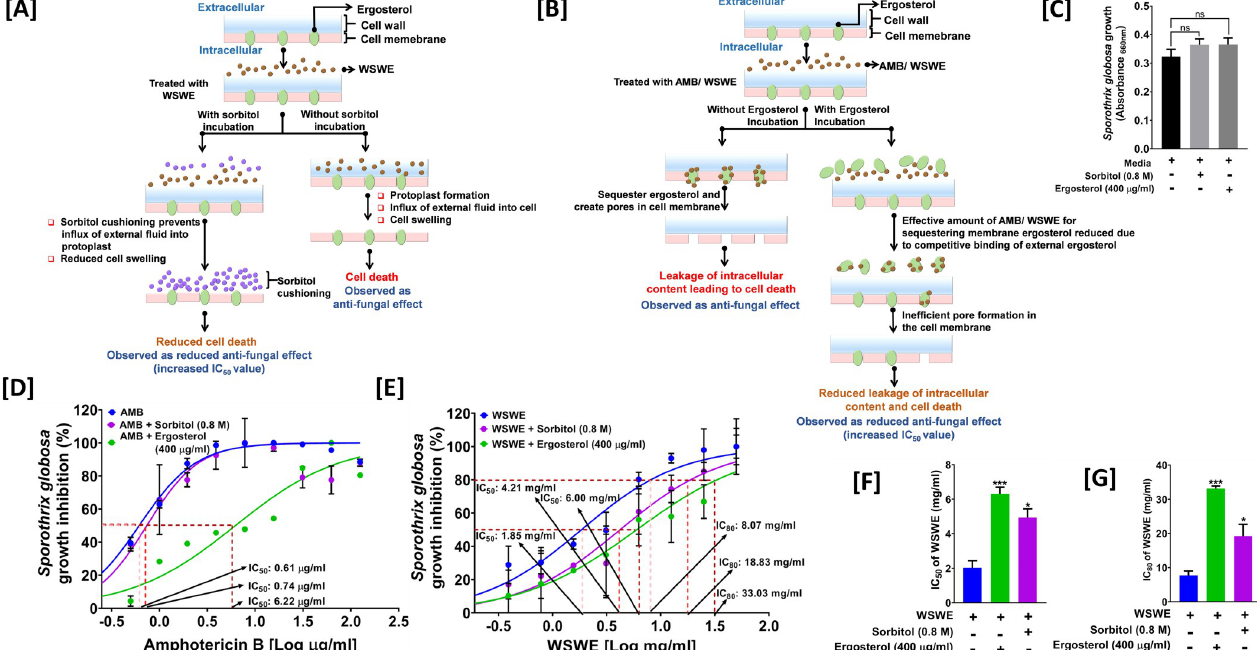
Fig 4. WSWE targets both cell wall and cell membrane of S . globosa . [A, B] Schematic depiction of the principles behind sorbitol protection (A) and ergosterol binding (B) assays to assess the effect of WSWE treatment on cell wall and cell membrane, respectively, of S . globosa . [C] Bar graph showing the effect of ergosterol or sorbitol alone on the growth of S . globosa cells. [D, E] Comparative dose response curves demonstrating the effect of sorbitol and ergosterol on the antifungal efficacies of amphotericin B (D) and WSWE (E) against S . globosa . [F, G] Bar graphs showing the changes in IC 50 (F) and IC 80 (G) values mentioned in (E). Data was individually fitted through non-linear regression and the obtained IC 50 (F) and IC 80 (G) values were averaged for plotting. Statistical significance was determined through 1-way ANOVA and represented as � and ��� for p < 0.05 and 0.001, respectively when compared to treatment with WSWE in the absence of ergosterol and